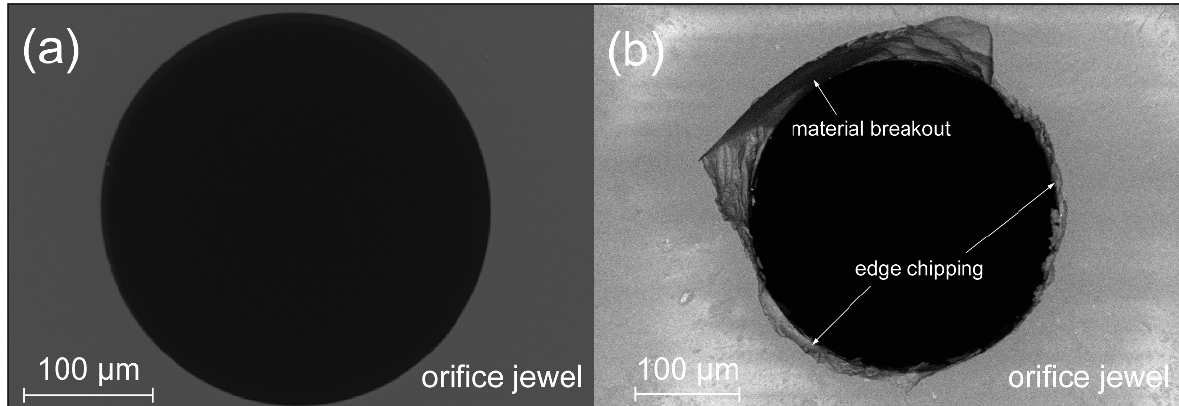
Figure 6. SEM images of ( a ) a virgin sapphire orifice jewel of a type 91 orifice with a bore diameter of 300 µm and ( b ) a damaged orifice jewel of a type 91 orifice with a bore diameter of 300 µm with material breakouts and edge chipping after 7:12 h of AWJ operation with an operating pressure of 300 MPa; the orifice was removed from the system after insufficient jet quality was detected.